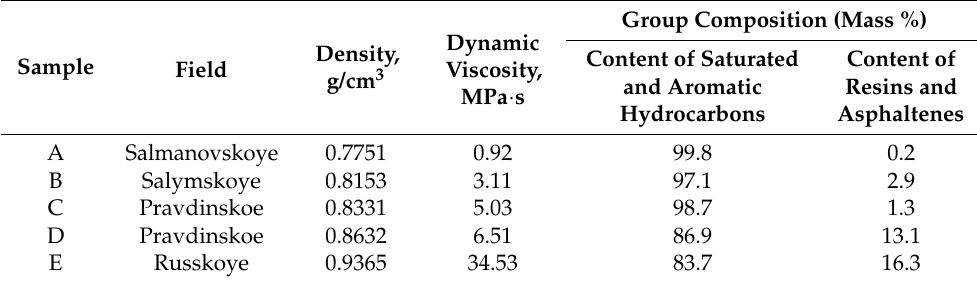
Table 1. Characteristics of the hydrocarbon fluids used in the study: oils and condensate from the fields of West Siberia. Sample Field